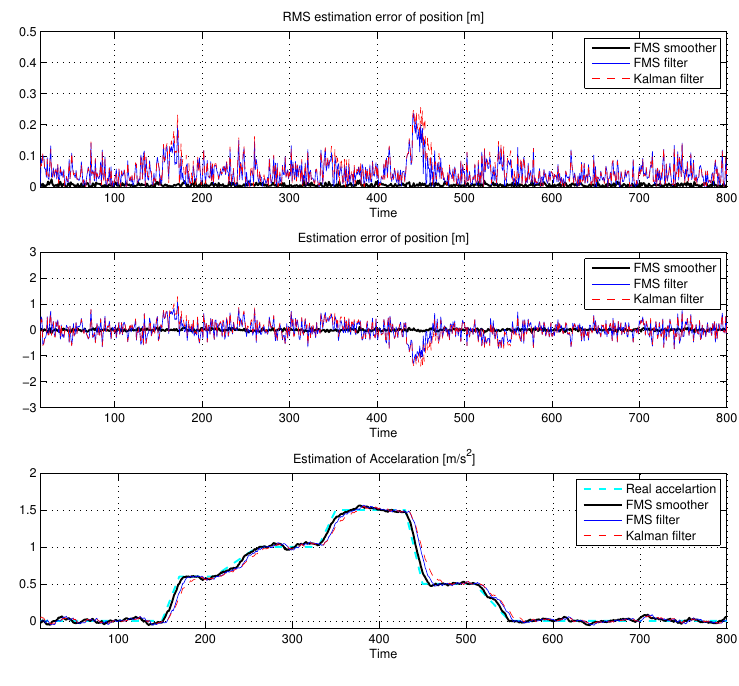
Figure 4. Simulation result for randomly changing